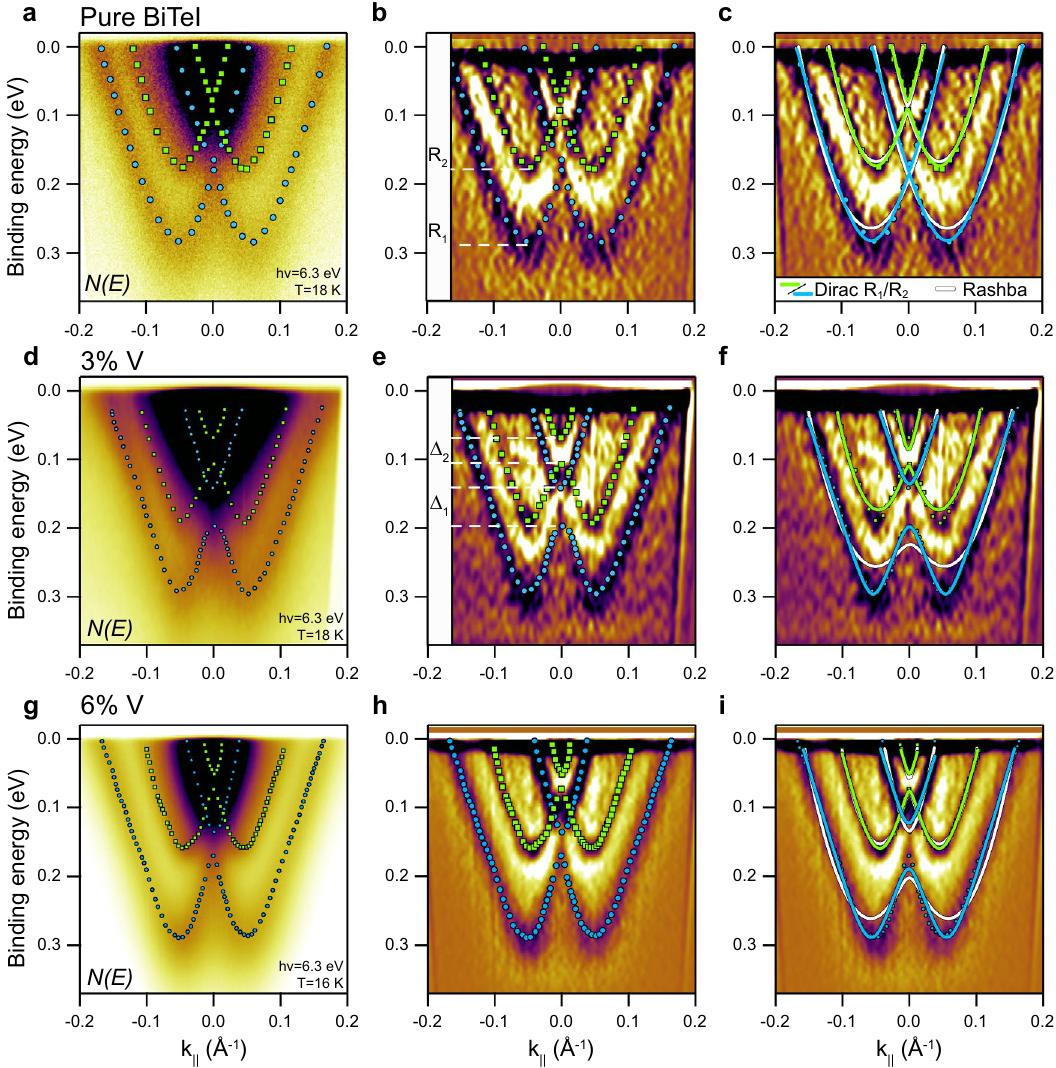
Figure 2. ( a ), ( d ), ( g ) ARPES dispersion relations N(E) measured with laser photoexitation (hv = 6.3 eV) for pure BiTeI and for 3% V and 6% V doped BiTeI. ( b ), ( e ), ( h ) EDC curvature plots of corresponding N(E) spectra with defined position of the first and second order Rashba states ( R 1 —blue circles and R 2 —green squares). (cid:31) 1 and (cid:31) 2 are KP gaps in the R 1 and R 2 states. ( c ), ( f ), ( i ) Approximation of the experimental points with two model functions: Rashba equation (white curves for both R 1 and R 2 ) and Dirac fermion equation (blue and green for R 1 and R 2 respectively). The fitting derived KP gaps for 3% V ( f ) with the Rashba model are (cid:31) R (cid:31) R 2 = 25 meV and with the Dirac model are (cid:31) D 1 = 62 meV, (cid:31) D 2 = 28 meV. The KP gaps for 6% V (i) are (cid:31)